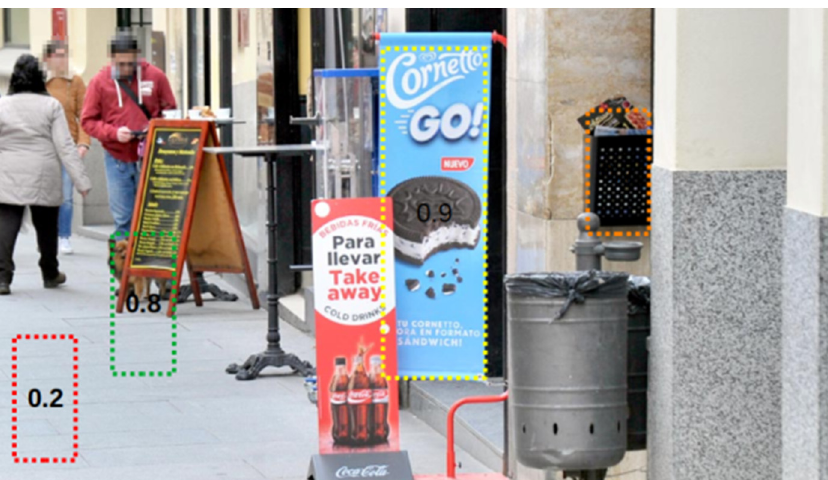
Figure 7. Illustrative image to show accumulated True Positive (TP), False Positive (FP), True Negative (TN) and False Negative (FN). Dotted rectangles in different colors represent the detections produced together with the confidence given by the network for each of them.